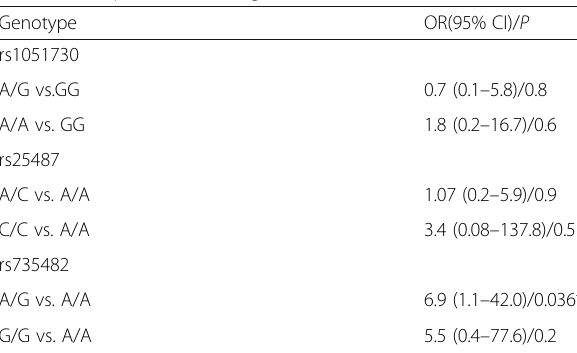
Table 5 Association between different genotypes and